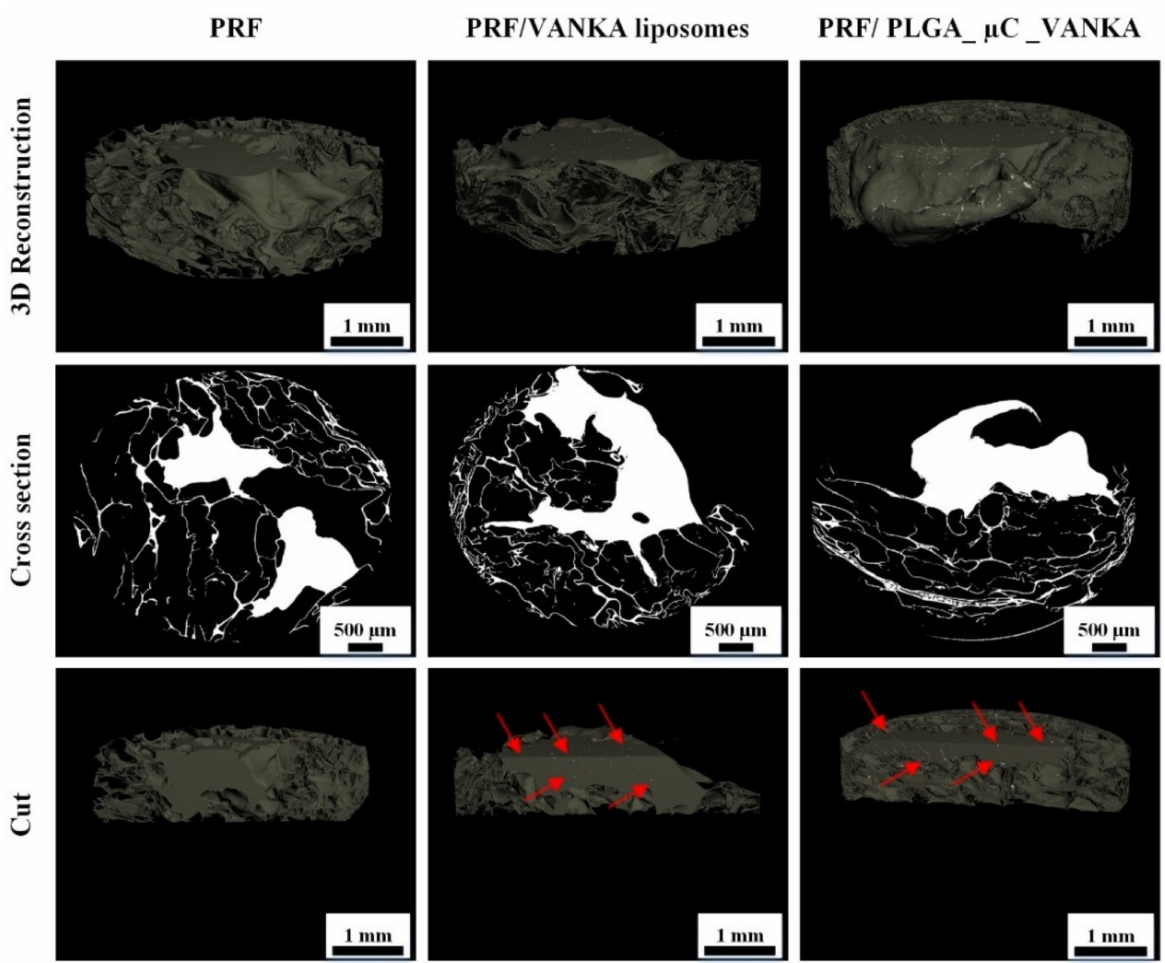
Figure 9. Micro-CT images of the PRF samples with VANKA liposomes (PRF/VANKA liposomes) and with VANKA microcapsules (PRF/PLGA_ µ C_VANKA) and the control samples without drug delivery systems (PRF); red arrows indicate the existence of delivery systems in the PRF samples.